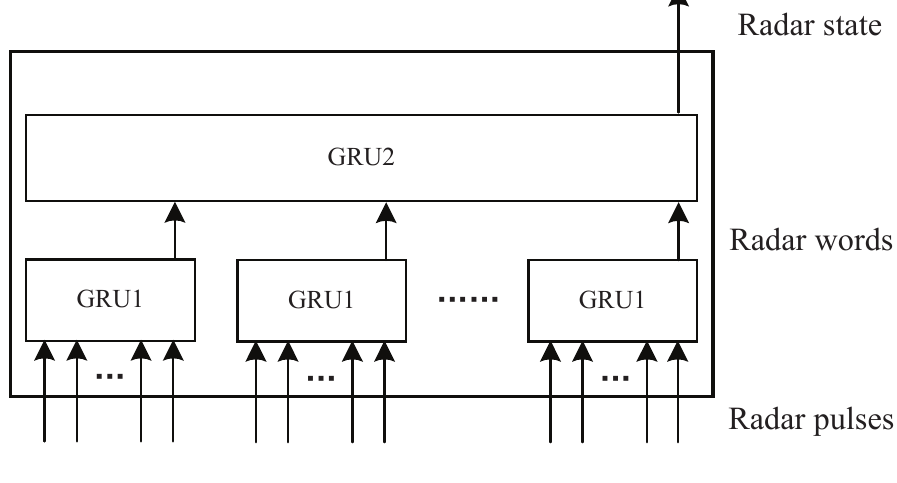
Figure 3. End-to-end recognition